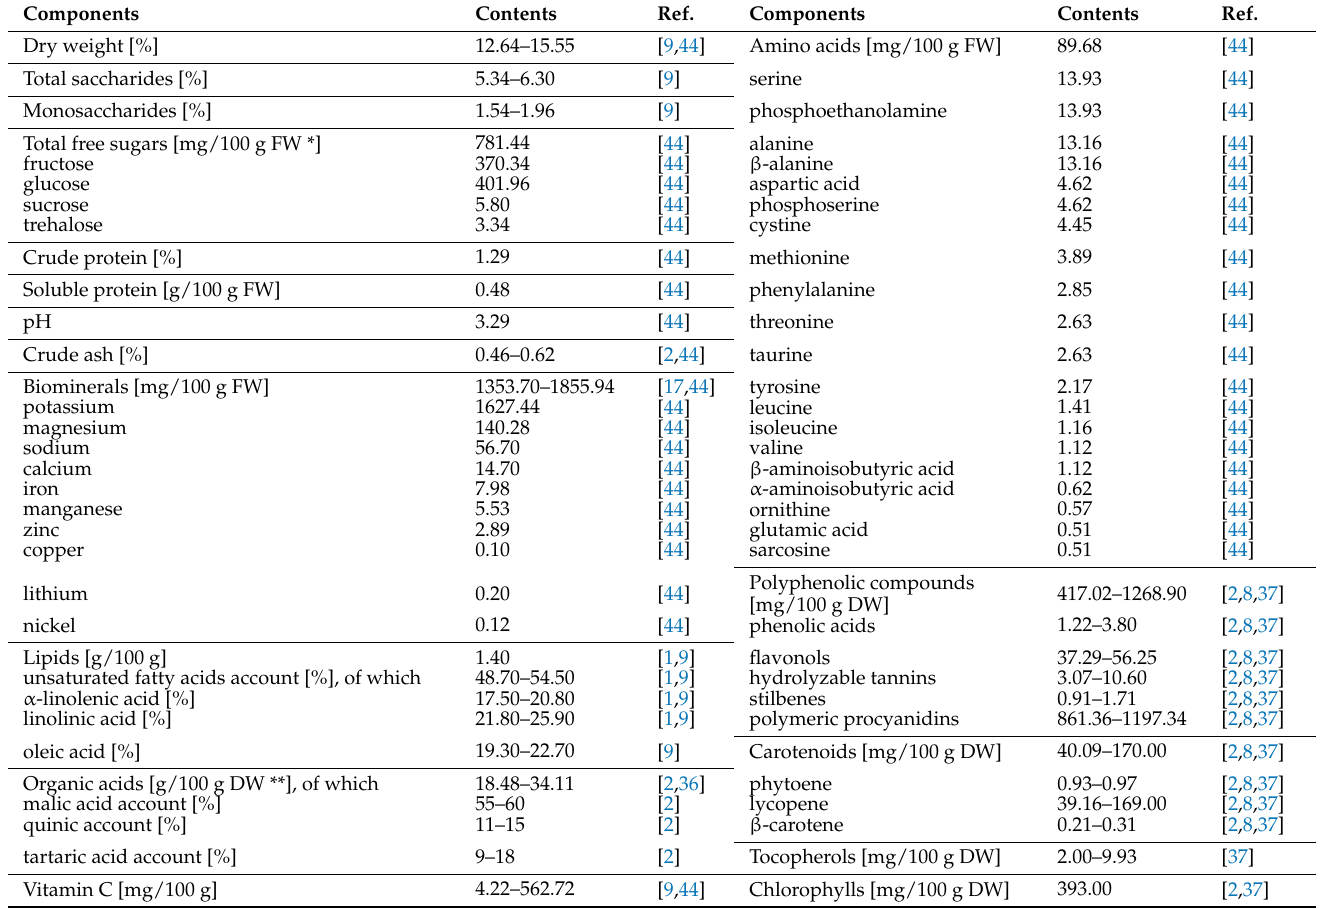
Table 1. The basic chemical composition of cherry silverberry